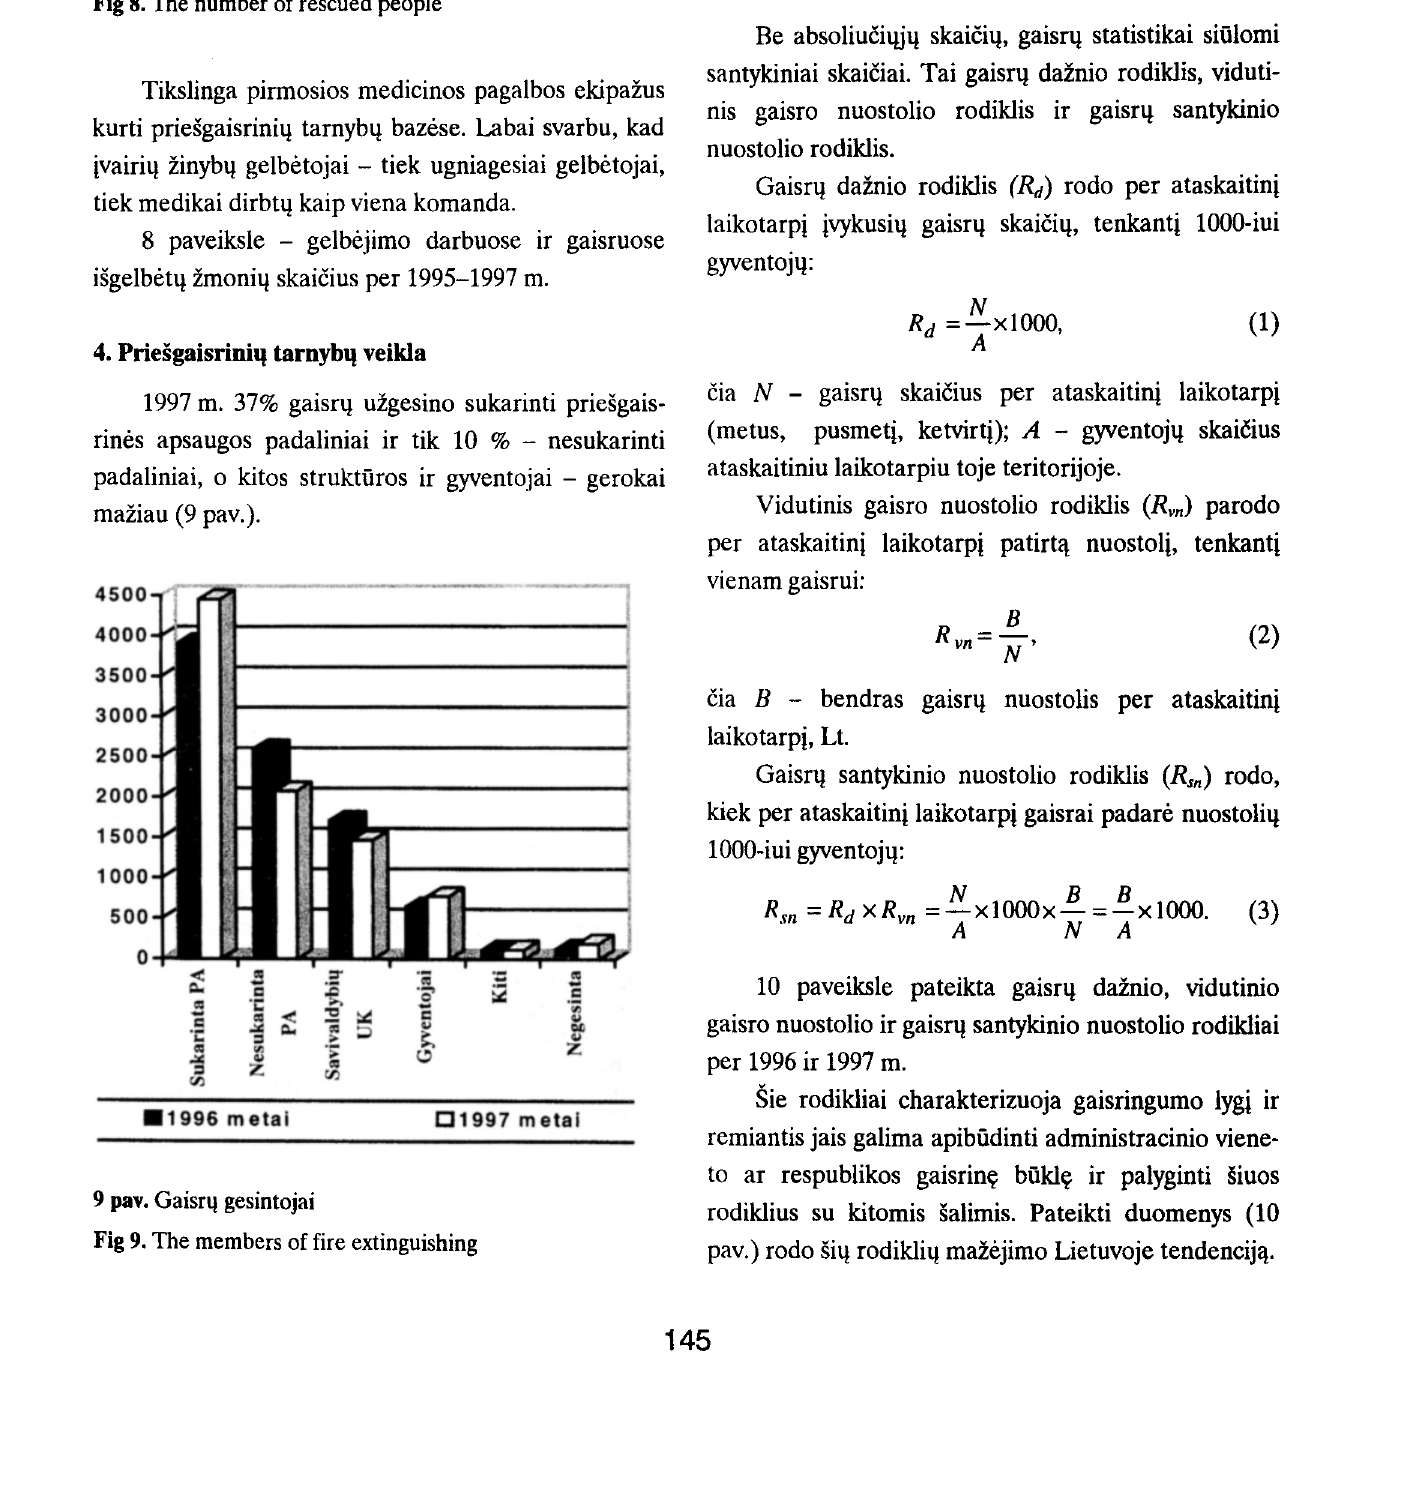
Fig 8. The number of rescued people